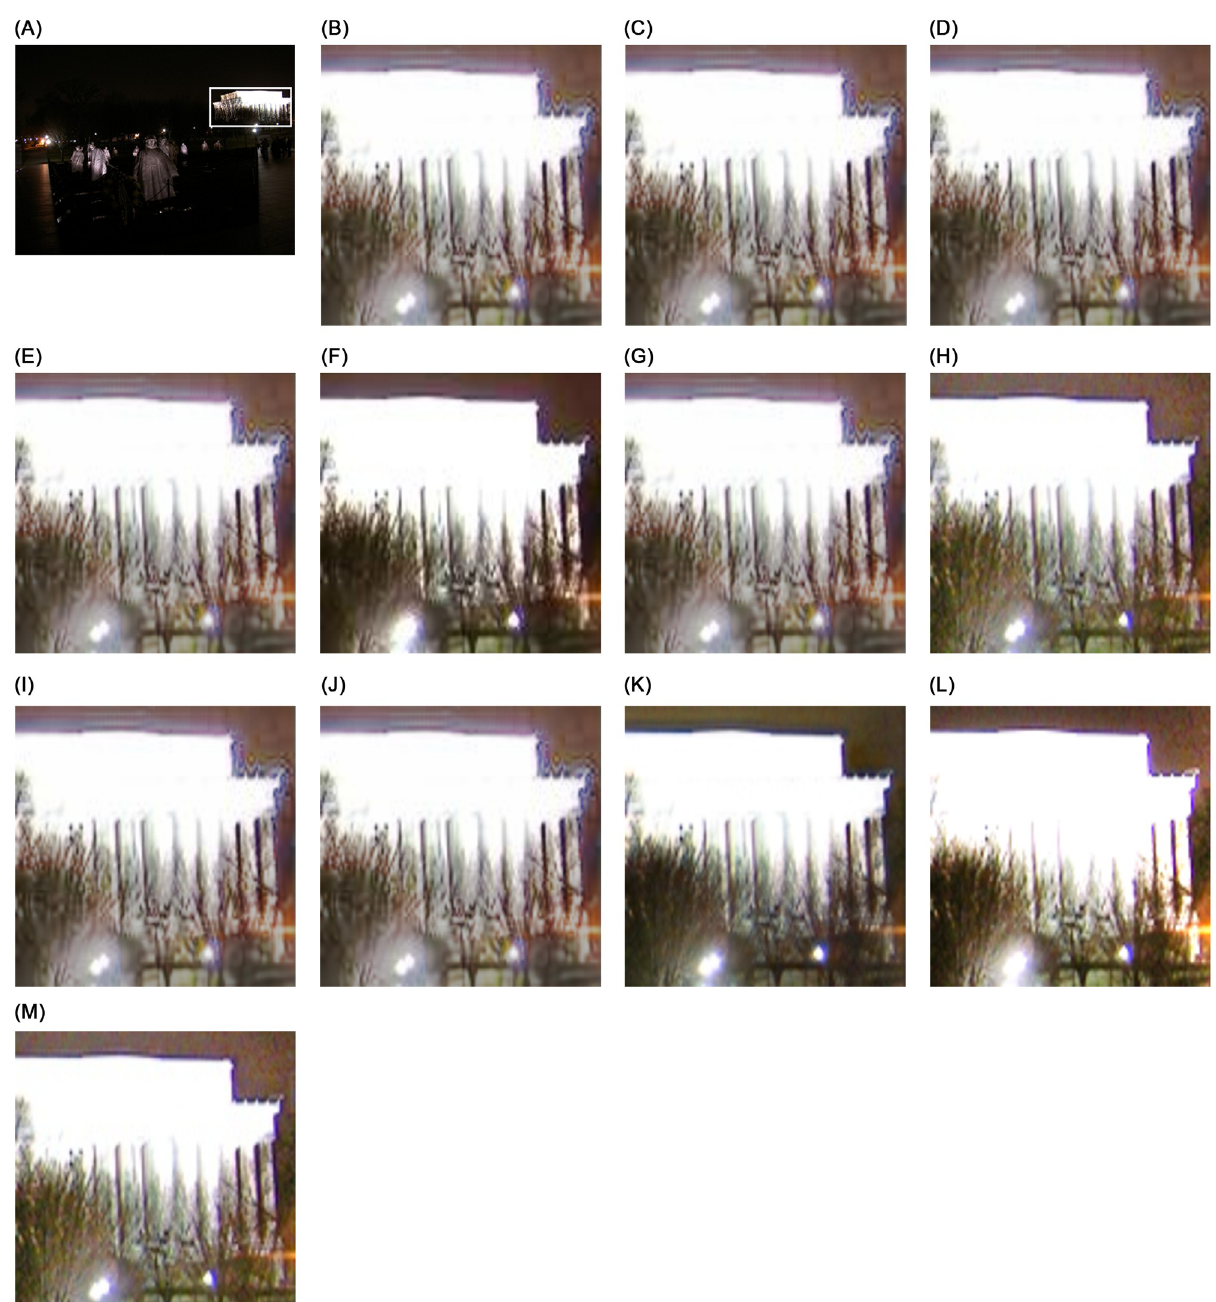
Fig 5. This figure compares the night-time image reconstruction performance. The figure shows the presence of noise and the trace of convolution in many of the restored images. In comparison to other methods, the proposed approach can recover the scene without perturbing the homogeneity of the foreground and background (for best view, zoom-in is